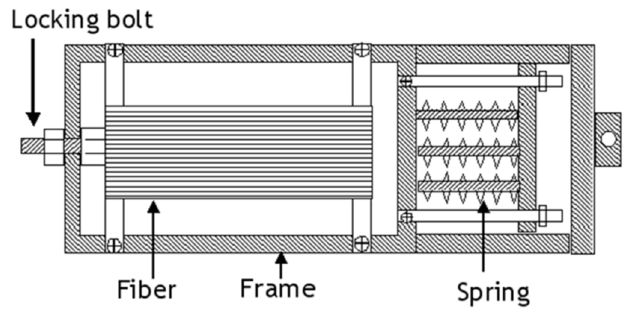
Figure 7. Schematic representation of a fibre-prestressing rig used by Zhao and Cameron.